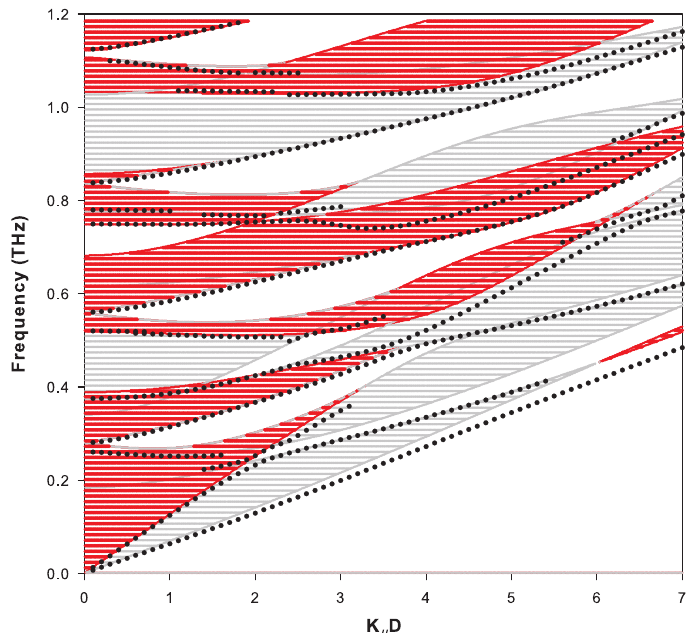
Figure 7. Dispersion of bulk bands and surface modes of an Si-graphene SL terminated by an Si layer of thickness d Si = 11 nm. The hatched areas with red and gray lines correspond to the bulk bands given by the two polarizations of the waves. Localized and resonant surface modes are represented by full circles.